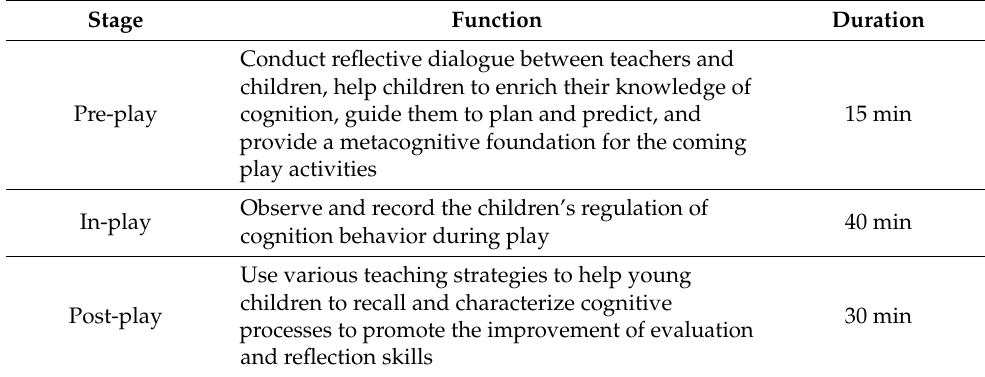
Table 2. Description of the three stages in the CCMT teaching